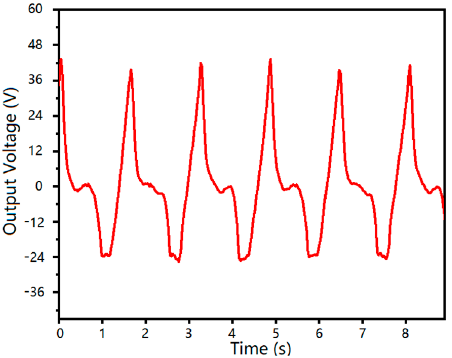
Figure 12. Output voltage of the designed stretchable and flexible energy harvester.